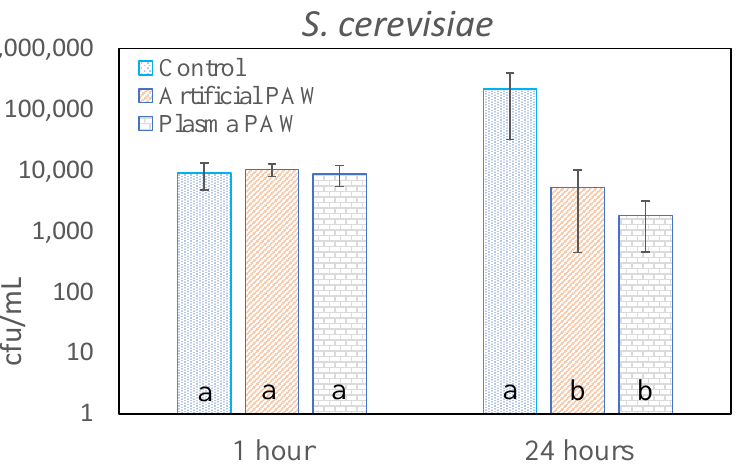
Figure 1. Inactivation of S. cerevisiae on inoculated wheat grains. Vertical bars indicate standard errors calculated from five parallel determinations. Significant differences at p < 0.05 are indicated by different letters. Separately determined results of PAW treatment after 1 h and 24 h are shown.